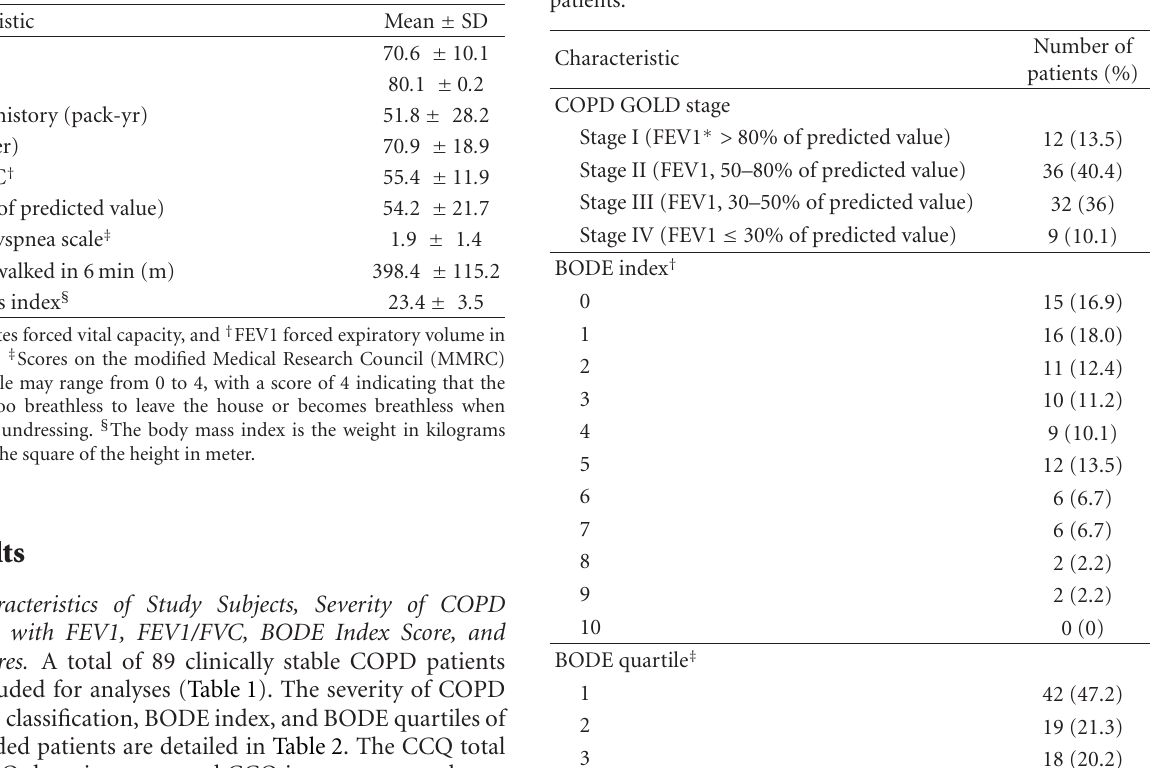
Table 1: Characteristics of 89 included men with clinically stable chronic obstructive pulmonary disease.